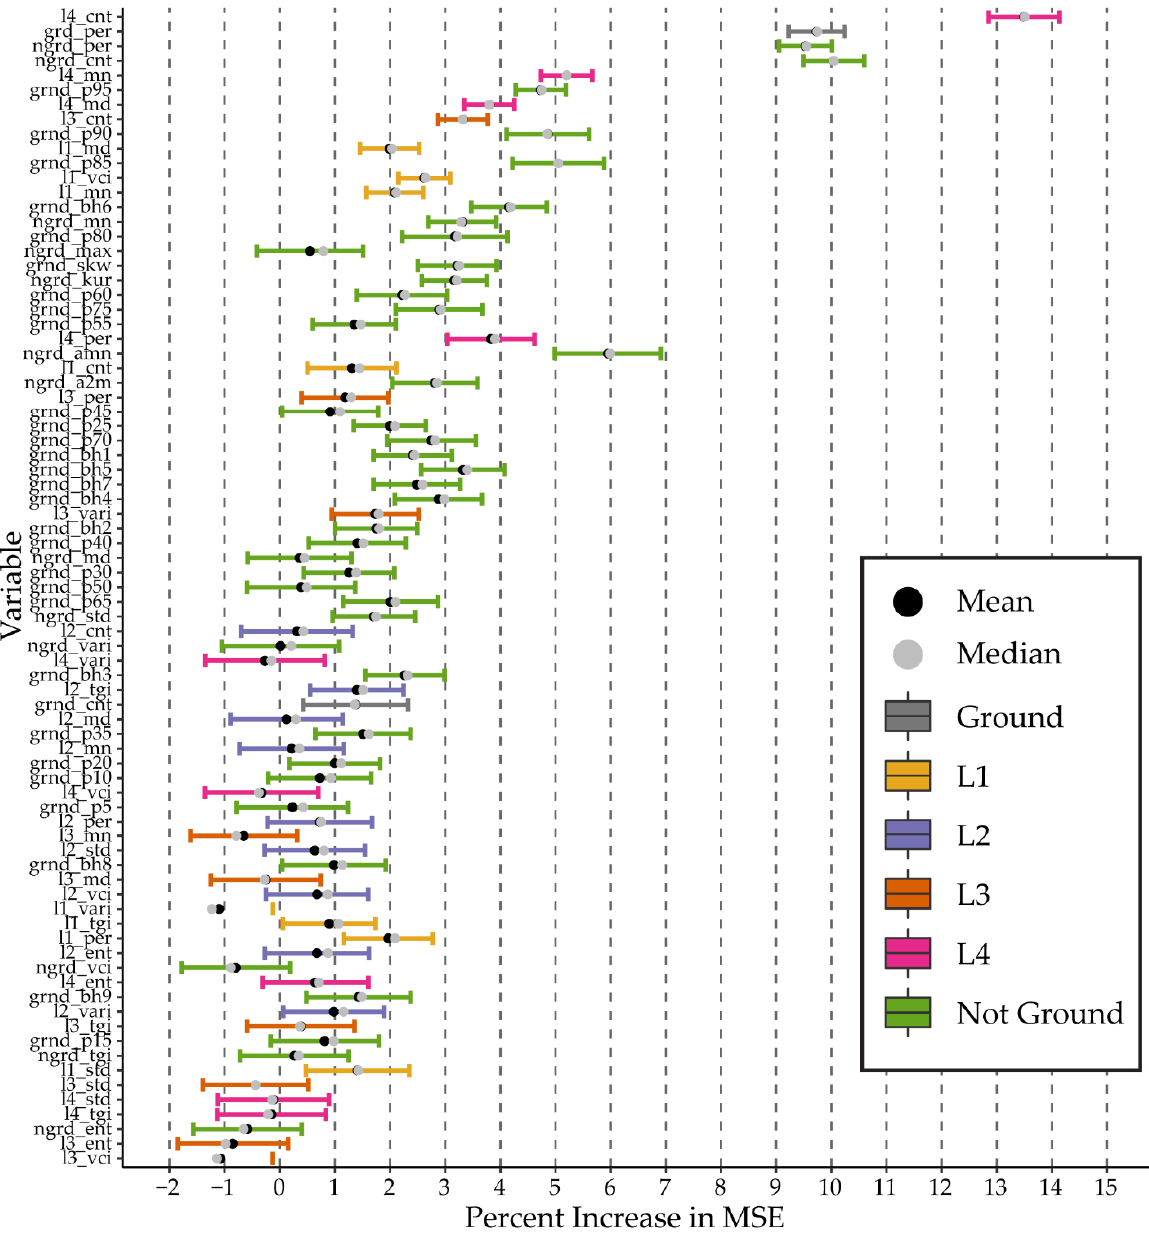
Figure 3. Variable importance estimates for predicting total CBI using standard RF-based method. Mean, median, and standard deviation where estimated from 500 separate model runs. Errors bars represent one standard deviation. The order of the variables is the same as in Figure 2 for comparison.